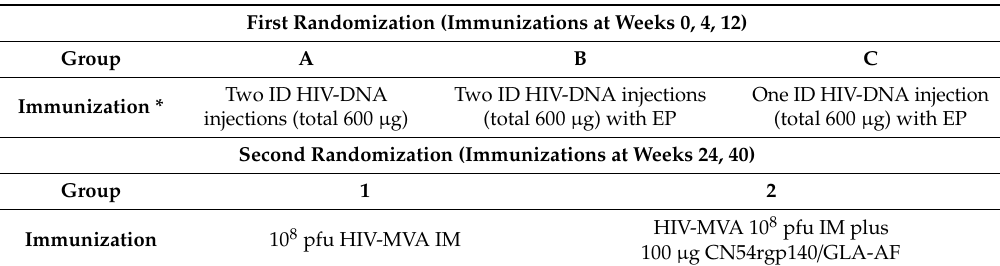
Table 1. Overview of the vaccination schedule used in the TaMoVac II trial